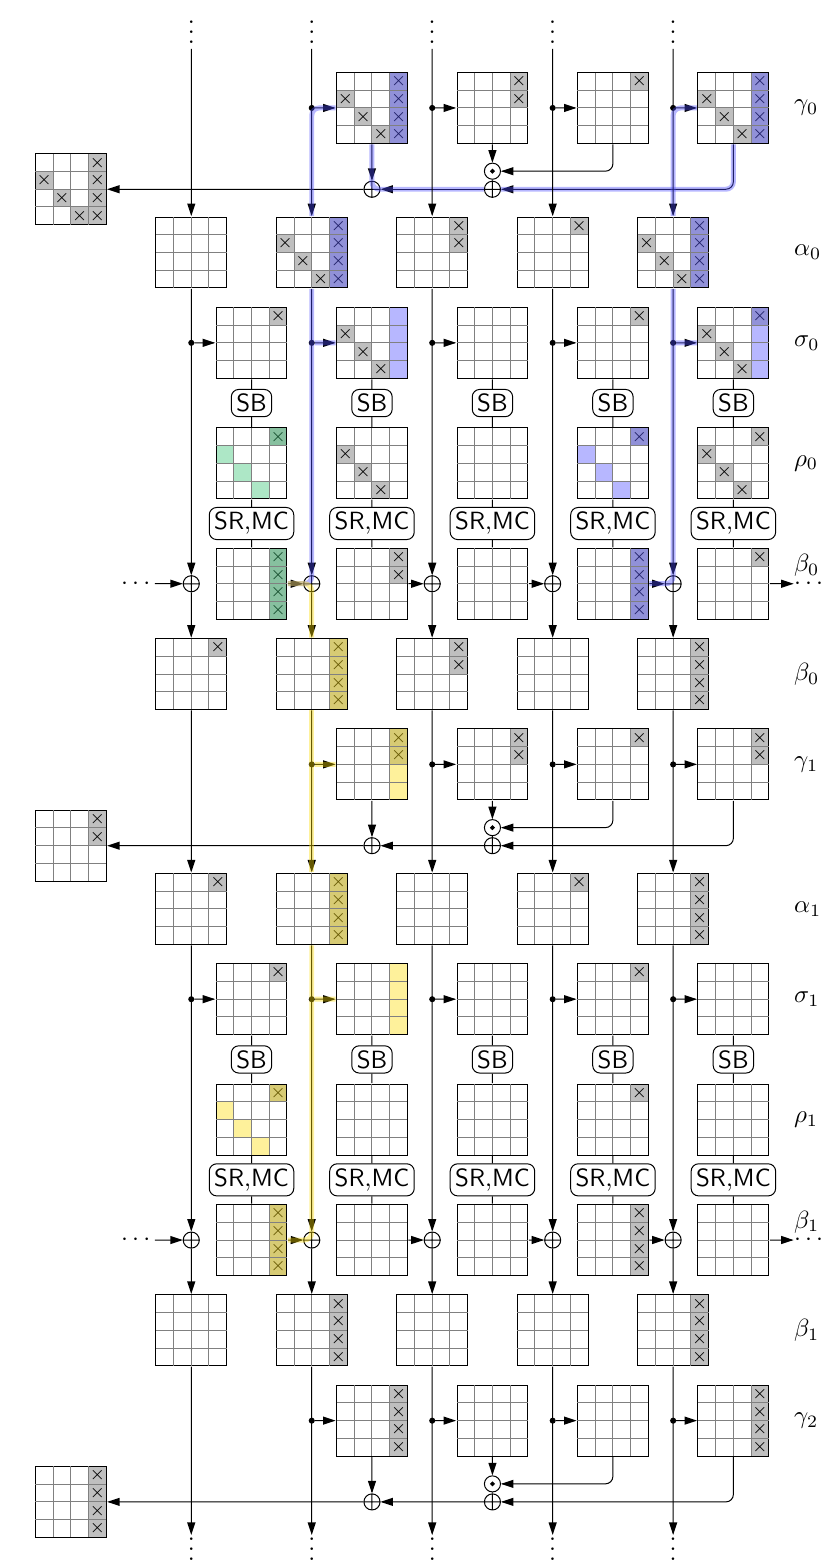
Figure 4: Inconsistent truncated linear characteristic for AEGIS -128 (11 S-boxes, 13 And s). Highlighted columns in blue+green or in yellow+green permit no bitwise consistent